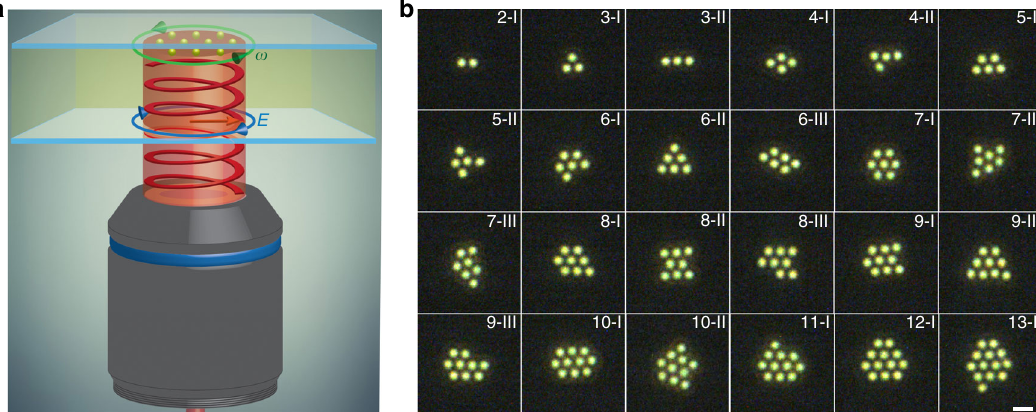
Fig. 1 Light-driven self-organization of silver NPs into mesoscale optical matter arrays. a Schematic of rotation of an optical matter array in a liquid sample cell illuminated by a circularly polarized laser beam. Blue arrow represents the rotation direction of the electric vector of light, and green arrow indicates the rotation direction of an array formed by optical binding of ten NPs. The NPs are experimentally observed from the point of view of the incident light source, where the electric vector rotates counterclockwise in the imaging plane. We use the convention that this is termed left-handed circularly polarized (LHCP). b Dark- fi eld optical images of representative optical matter arrays consisting of 2 – 13 150 nm diameter silver NPs. The scale bar is 1 µ